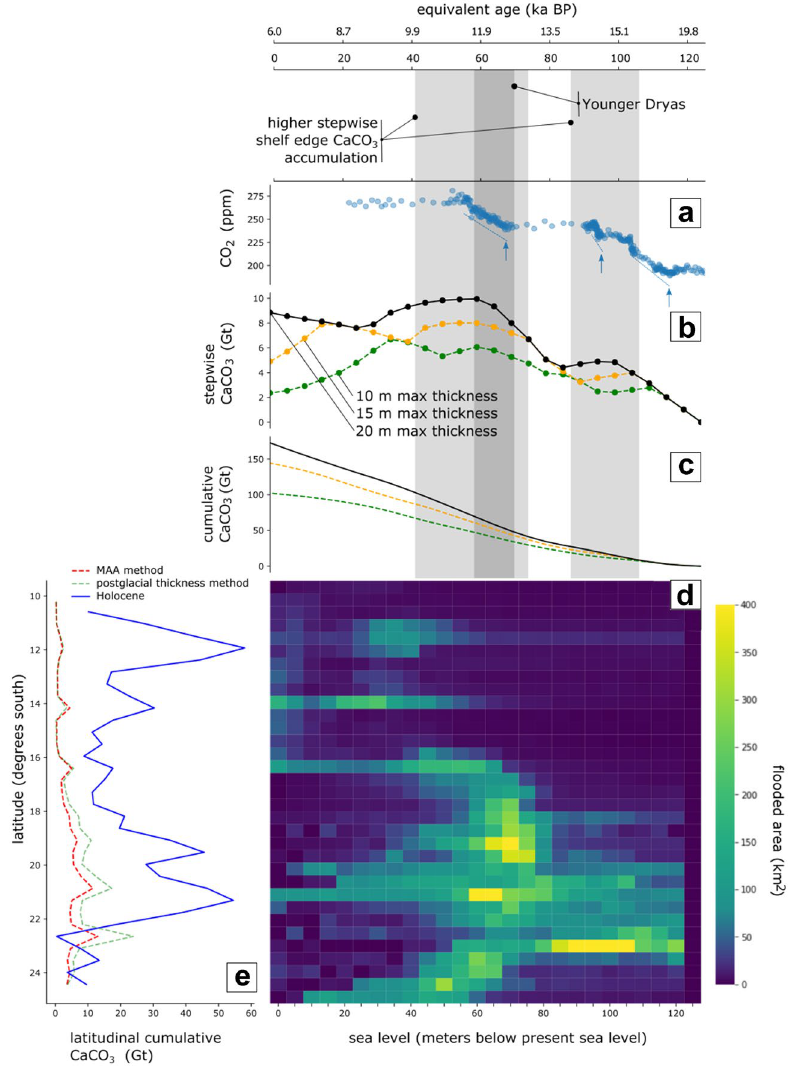
Figure 3. Summary of shelf edge reef deposits in the GBR: ( a ) atm-CO 2 67 data from Antarctic ice cores, intervals of increased rate are highlighted in blue; ( b ) stepwise shelf edge reef deposits; ( c ) cumulative shelf edge CaCO 3 increase for different maximum accretion thicknesses, ( d ) shelf edge CaCO 3 mass deposits for every latitudinal zone and for every past sea level 5 m increase; ( e ) comparison of the latitudinal distribution of CaCO 3 mass deposits (best-estimate case) for the Holocene reefs and the shelf edge reefs according to the two applied methods. Notice the increase of the values between 18° and 22° S where the shelf is